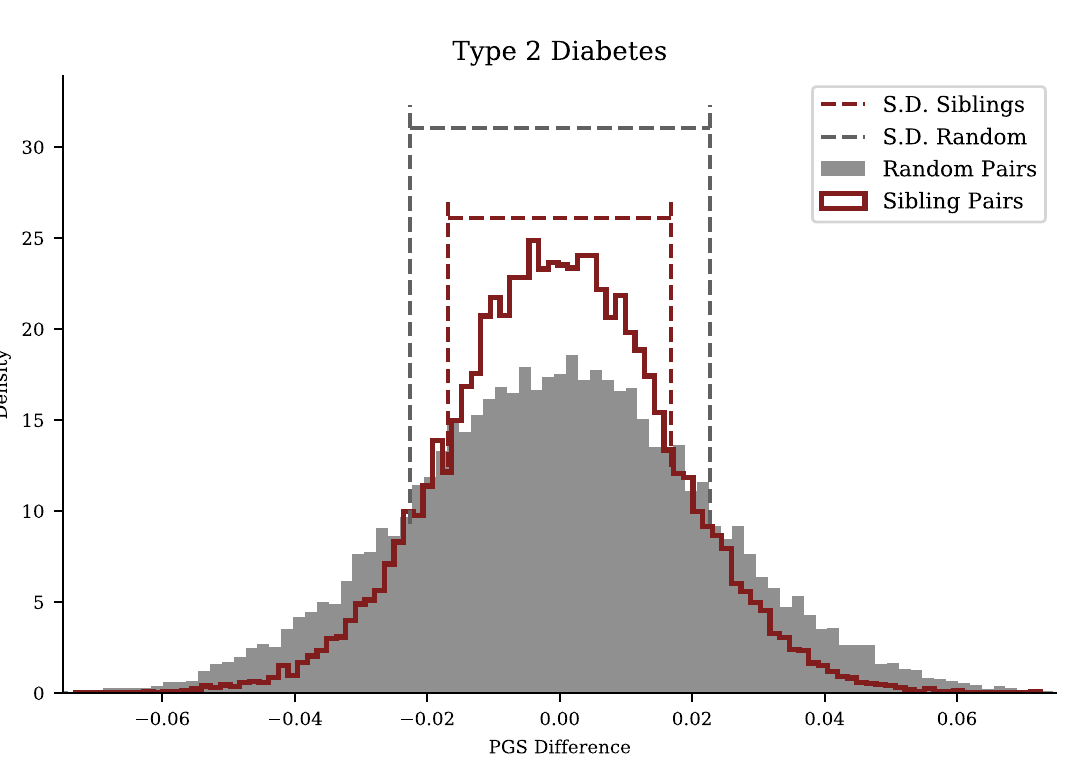
Figure 3. Type 2 Diabetes PGS: sibling variation smaller but still significant. Difference in PGS for Type 2 Diabetes in pairs of siblings and pairs of unrelated individuals from the general UKB population. The width √ 2 times smaller, but still significant. The dashed lines mark the of the sibling distribution is, as expected, ∼ standard deviations for the